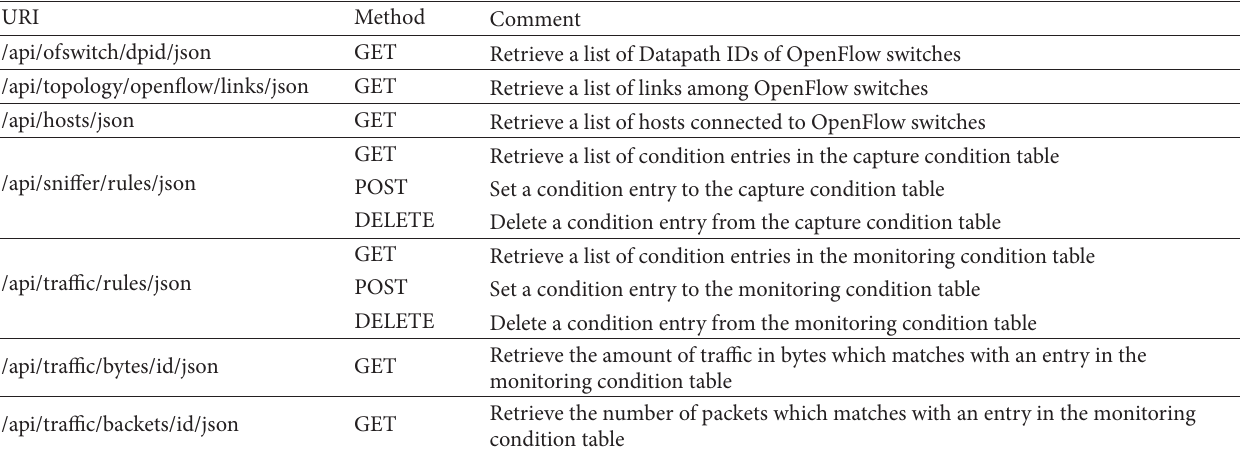
Table 3: List of REST